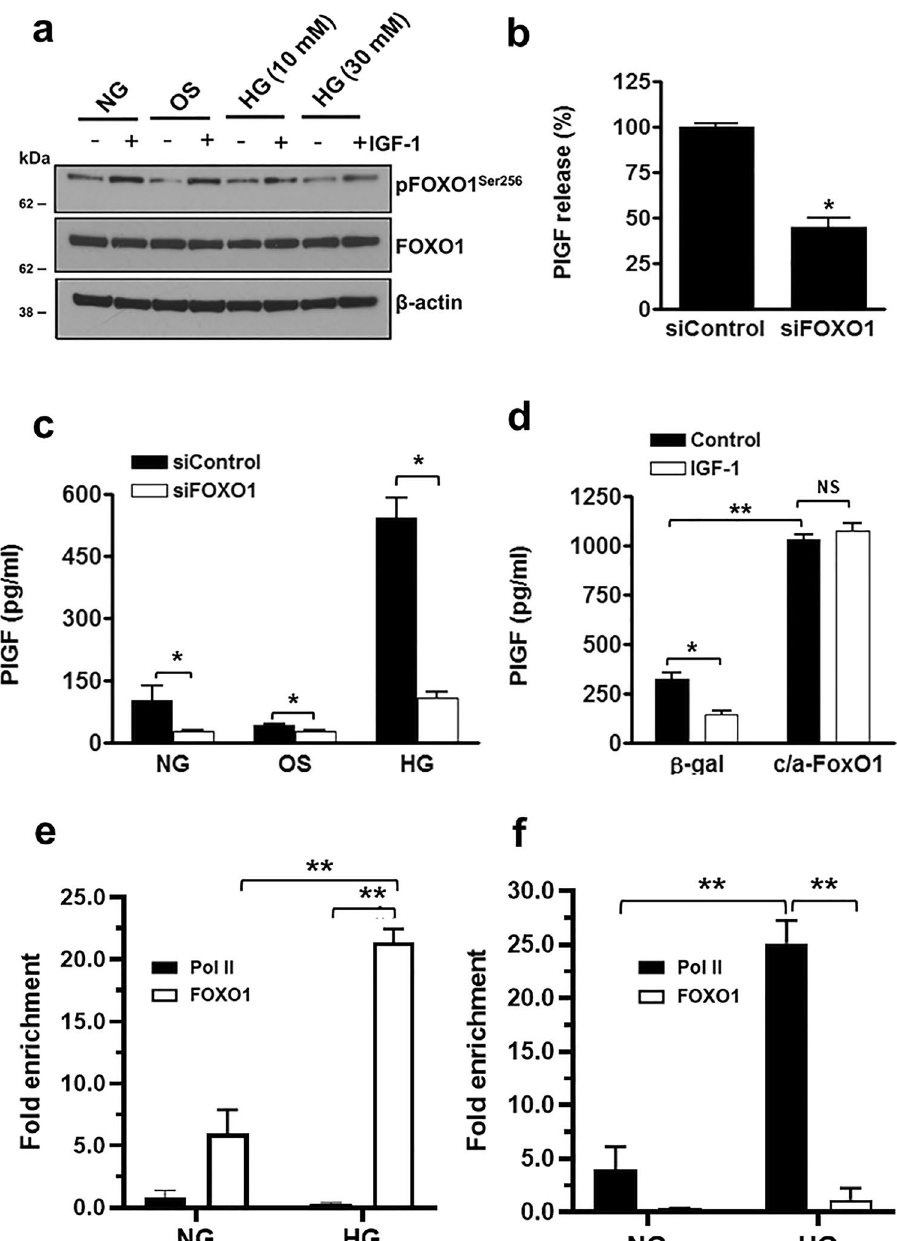
Figure 4. Increased FOXO1 activity induces PlGF expression and release. ( a ) Confluent HUVEC were maintained in normoglycaemia (NG = 5 mM l-glucose), hyperglycaemia (HG = 10, or 30 mM d-glucose) or osmolarity control medium (OS = 5 mM d-glucose + 25 mM l-glucose) and then stimulated with IGF-1 (10 ng/ ml) for 10 min, and cell lysates Western blotted for phospho-FOXO1 ser256 , FOXO1 and β-actin (reused from Fig. 1d), with unedited blot images in Supplementary Fig. S5. ( b ) HUVEC were electroporated with FOXO1 (siFOXO1) or control (siControl) siRNAs PlGF secretion into the culture medium quantified by ELISA. ( c ) HUVEC were cultured in NG, HG, or OS for 24 h and stimulated with IGF-1 (10 ng/ml) for 10 min. ( d ) HUVEC infected with ca-FoxO1 and Ad-CMV (control) adenoviruses overnight, then incubated with IGF-1 (10 ng/ml) and PlGF quantified in cell supernatants by ELISA. Quantitative PCR detection of FOXO1 and Pol II enrichment to ( e ) the identified FOXO1 DNA binding site in the PlGF promoter and ( f ) region containing the TATAA box proximal to the PlGF transcription start site, relative to negative control DNA region (NegC) using ChIP assays. Results are the mean (± SEM) of ≥ 3 independent experiments and analysed using ( b – d ) Student’s t-test and ( e,f ) one-way ANOVA, Tukey’s post hoc test; *P < 0.05, **P <